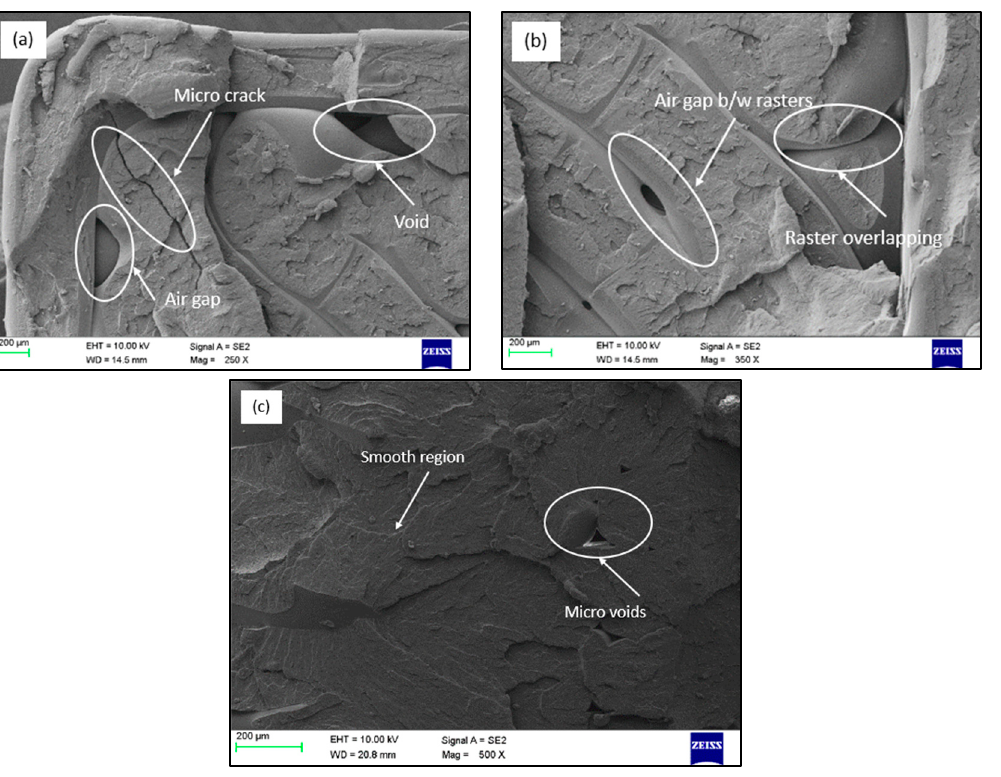
Figure 6. White light interferometry 3D surface profiles for samples fabricated at different layer thicknesses of ( a ) 0.1 mm, ( b ) 0.2 mm and ( c ) 0.3 mm.